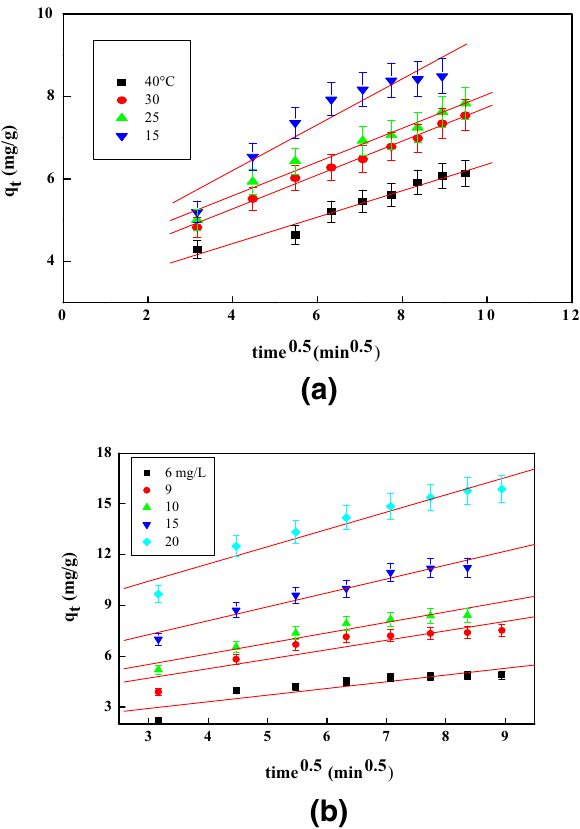
Fig. 12 Plot of intra-particle diffusion modeling of diazinon onto PCW at various temperatures ( a ) and concentrations ( b )